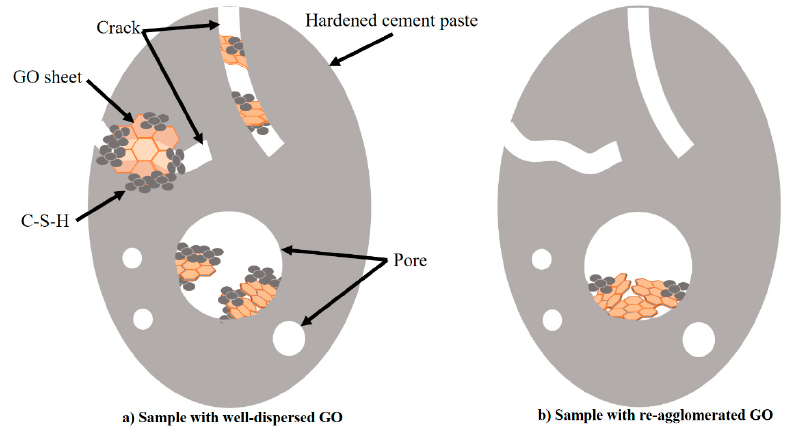
Figure 9. Schematic illustration of GO reinforcement of hardened cement paste: ( a ) sample with well-dispersed GO and ( b ) sample with re-agglomerated GO.